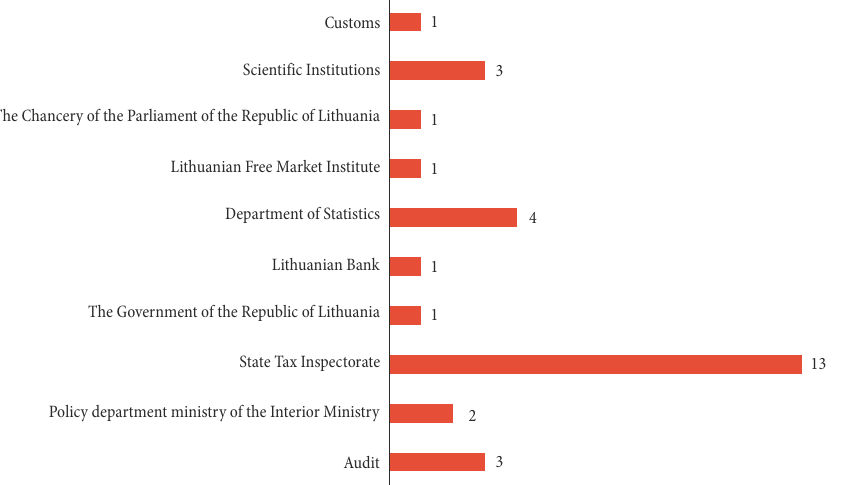
Fig. 2. Distribution of the experts by operation fields, in persons